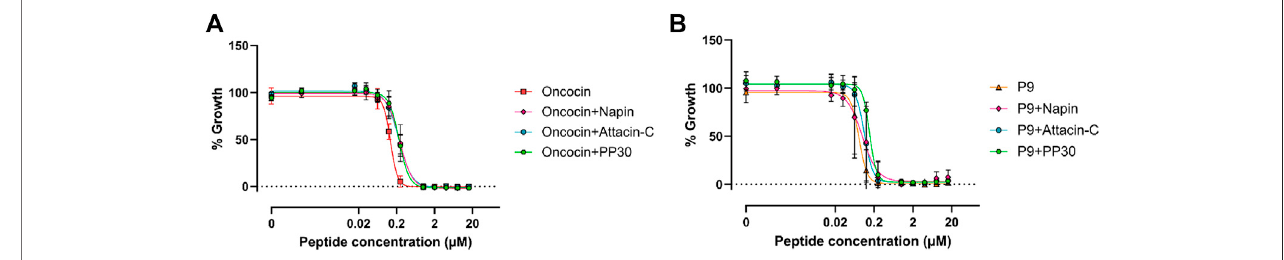
FIGURE 3 | Minimum inhibitory concentrations of antibacterial active and inactive PrAMPs against E. coli ATCC 25922. (A) MIC assessment of oncocin with/ without antibacterial napin/PP30/attacin-C. (B) MIC assessment of P9 with/without antibacterial napin/PP30/attacin-C. Each peptide is present in equimolar concentration with the individual concentration shown in the X